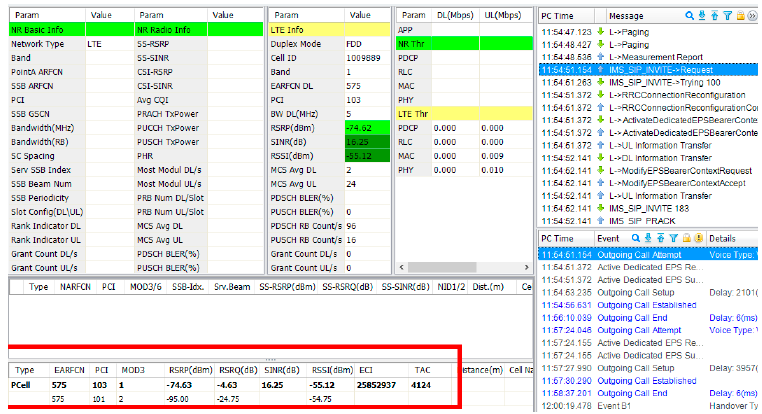
Figure 11. Sharer 5G VoLTE setup.